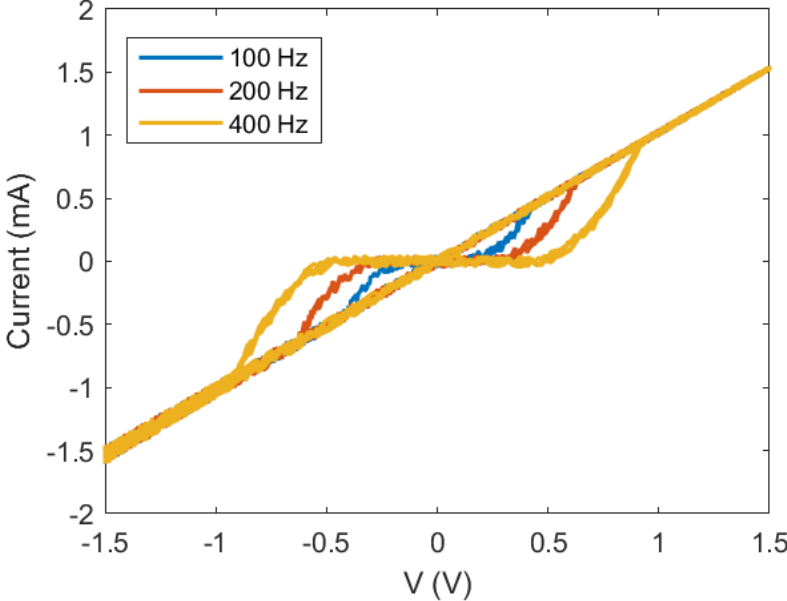
Figure 13. Measured I-V signals at different